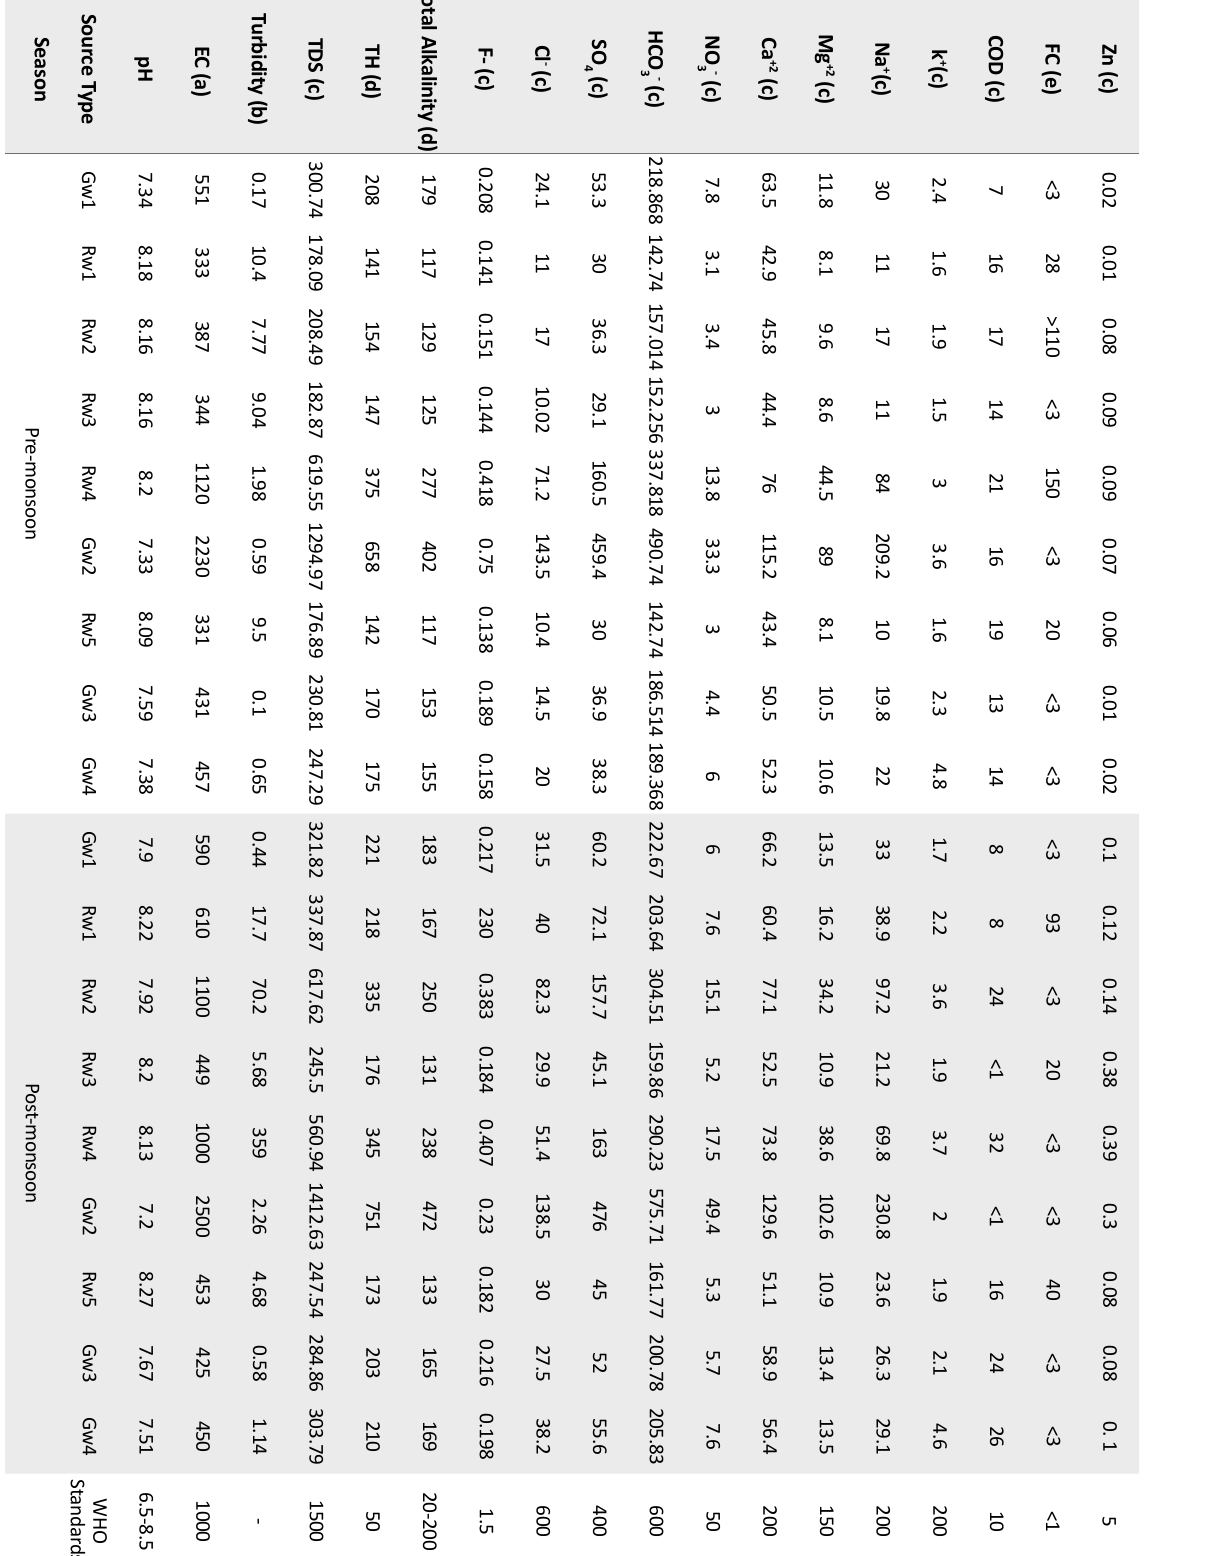
Table 3. River and groundwater quality in the study